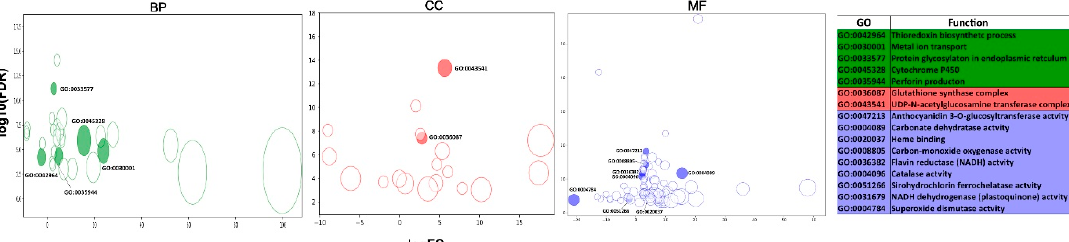
Figure 3. Hierarchical clustering analysis of the C. velia control (Cvel_cont1, Cvel_cont2, and Cvel_cont3) and Hg-treated libraries (Cvel_mer1, Cvel_mer2, and Cvel_mer3).